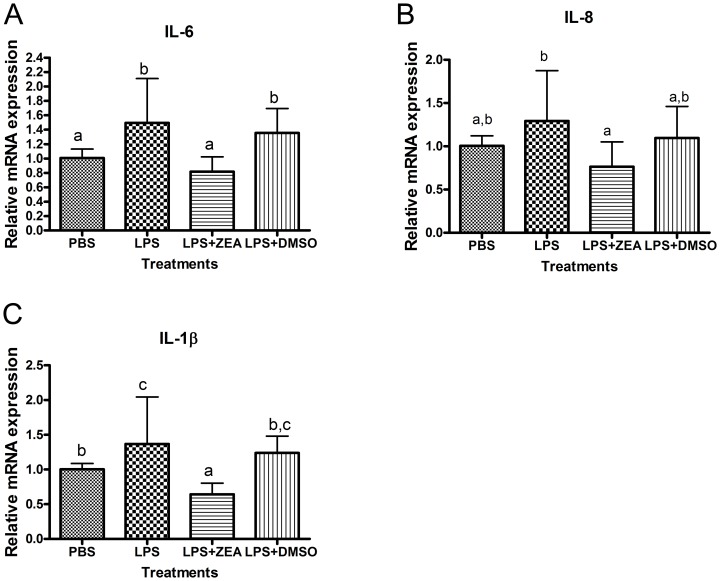
Quantitative PCR showing mRNA expression of inflammatory cytokines and chemokines in LPS stimulated BEAS-2B cells.The mRNA expression of β–actin was used for normalization. (A) Interleukin 6 (IL-6). (B) Interleukin 8 (IL-8). (C) Interleukin 1, beta (IL-1β). Results represent the mean± SD of at least 3 independent experiments and bars with different alphabets show significant differences (One-way ANOVA, p<0.05).